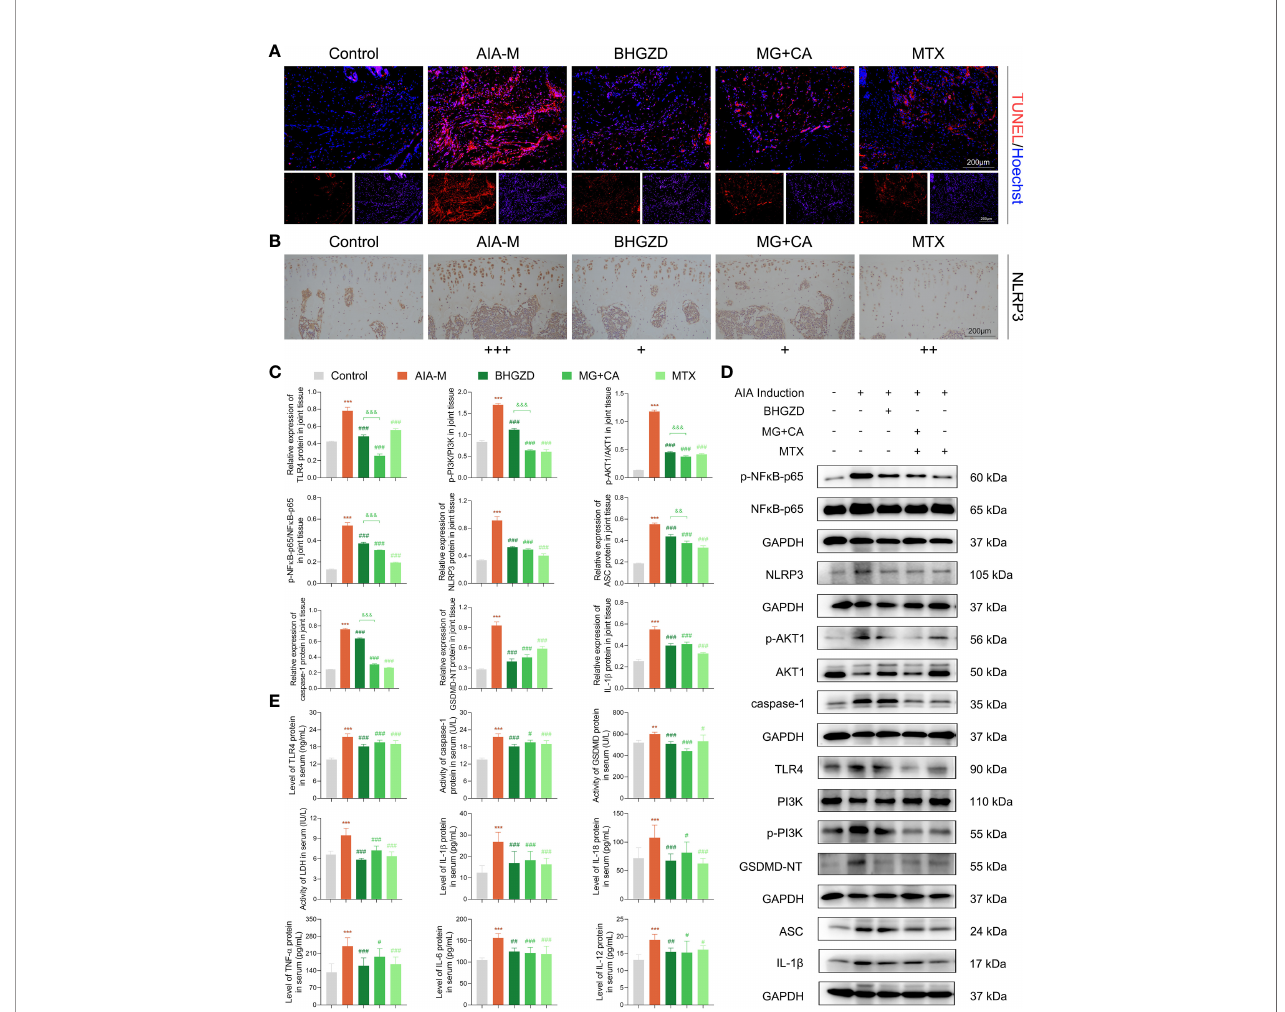
FIGURE 4 | Regulatory effects of BHGZD, the two-BAC combination, and MTX on the expression of TLR4, p-PI3K/PI3K, p-AKT1/AKT1, p-NF k B-p65/NF k B-p65, NLRP3, ASC, caspase-1, GSDMD-NT, IL-1 b , IL-18, IL-6, TNF- a , and IL-12 in AIA-M rats of different groups (Control, AIA-M, BHGZD, MG+CA, and MTX). (A) Representative images of pyroptosis in the knee joints of AIA-M rats detected by deoxynucleotidyltransferase-mediated UTP end labeling (TUNEL) assay (scale bar represents 200 m m, TUNEL red, Hoechst blue). (B) The expression of NLRP3 protein in the knee joints of AIA-M rats (scale bar represents 200 m m). (C, D) The protein expression of TLR4, p-PI3K/PI3K, p-AKT1/AKT1, p-NF k B-p65/NF k B-p65, NLRP3, ASC, caspase-1, GSDMD-NT, and IL-1 b in the knee joints of AIA-M rats using Western botting analysis ( n = 3 per group). (E) The expression levels of TLR4, TNF- a , IL-6, IL-1 b , IL-18, and IL-12 in the sera of AIA-M rats using enzyme- linked immunosorbent assay (ELISA) analysis, and the activities of caspse-1, GSDMD-NT, and LDH in the sera of AIA-M rats using ELISA analysis ( n ≥ 3 per group, all experiments were performed in triplicate). Data are expressed as the mean ± SD. **, ***, p < 0.01, p < 0.001, respectively, comparison with the normal control group; #, ##, ###, p < 0.05, p < 0.01, p < 0.001, respectively, comparison with the AIA-M model group; &&, &&&, p < 0.01, p < 0.001, comparison with the treatment of